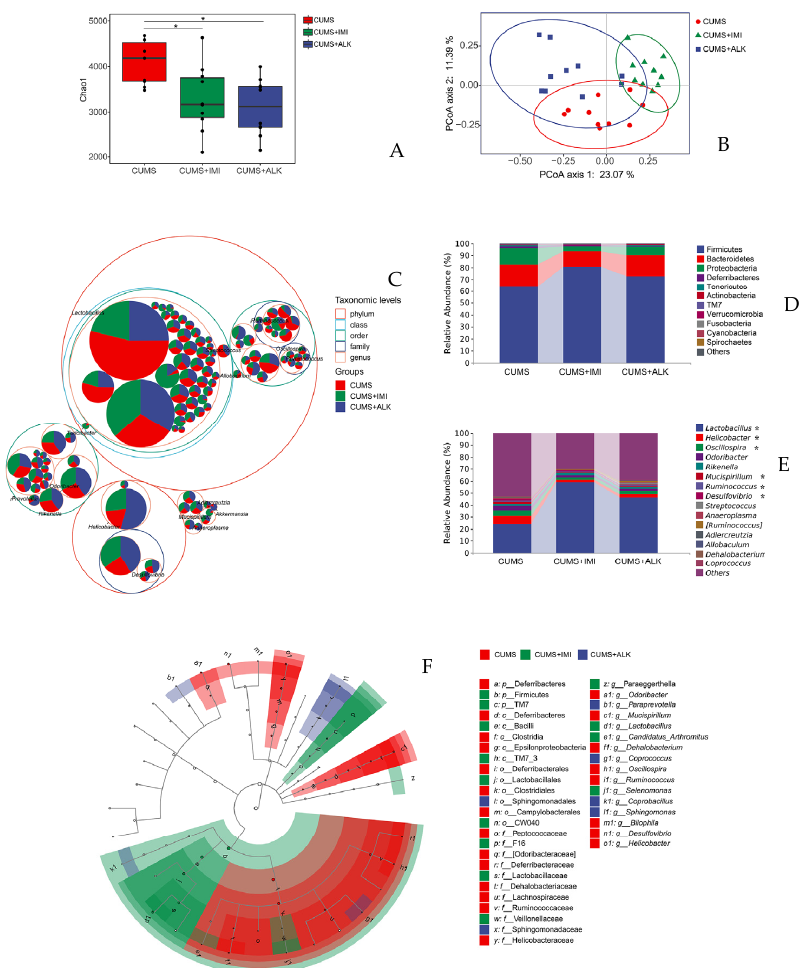
Figure 2. Composition and relative abundance of gut microbiota of mice subjected to chronic un- predictable mild stress (CUMS). The four groups are mice divided into no CUMS, CUMS (CUMS+ vehicle (0.9% saline)), CUMS mice treated with imipramine (CUMS + imipramine), and alkaloids (CUMS + alkaloids). ( A ) Chao1 index of imipramine and alkaloids-treated mice was reduced, but there was no significant difference in their diversity compared to saline treated CUMS mice. ( B ) The principal coordinates analysis (PCoA) based on the Bray–Curtis distance for GM showed a signifi- cant difference in microbial clusters among CUMS + imipramine and CUMS + alkaloids groups. Ellipses refer to 95% confidence intervals between treatments. ( C ) Taxonomic tree of GM repre- sented in packed circles. The phylum level is denoted by the largest circles, while the inner circles are denoted by class, order, family, and genus. Firmicutes, Bacteroidetes, and Proteobacteria are found to be the dominant phyla. ( D ) Treatment with imipramine and alkaloids increased the Fir- micutes, and decreased Bacteroidetes and Proteobacteria content. ( E ) Bar chart represents the spe- cific changes in the relative abundance of GM between CUMS, CUMS + imipramine and CUMS + alkaloids groups at the genus level. * Denotes significant differences in specific microbes between groups. ( F ) Linear discriminant analysis scores on the cladograms of amplicon sequence variant is more than 2 based on linear discriminant analysis effect size [156]. 3.3. Experimental Studies in Mice Treated with Antibiotics SPF mice receiving cocktail of neomycin, bacitracin and pimaricin showed GD to be accompanied by increased exploratory behavior, reduced anxiety, and altered BDNF lev- els in the hippocampus and amygdala [157]. SPF mice (infected with Citrobacter